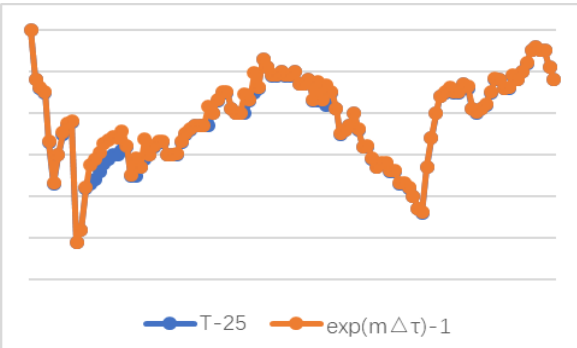
Fig. 3 Variation Trend of Optical Thickness Difference and Temperature Difference. As can be seen from the figure, the two have a good linear correlation.